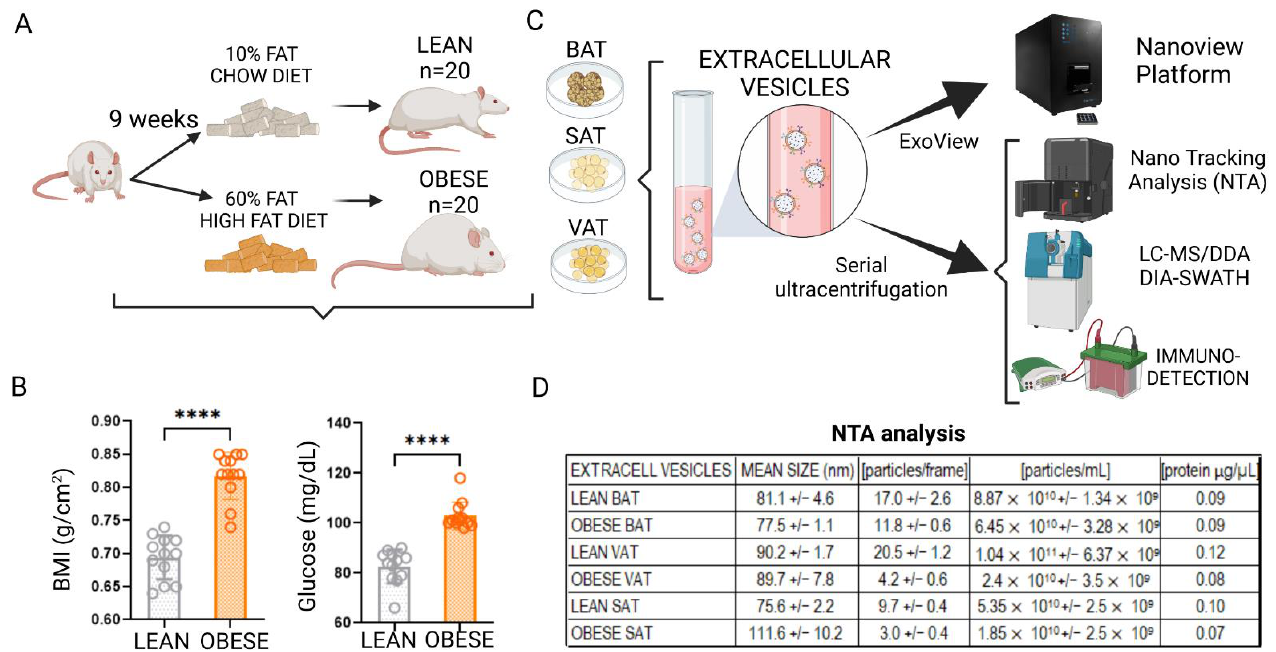
Figure 1. Establishment and characterization of a model of diet-induced obesity (DIO) for EV isolation. ( A ) A schematic of the animal model for obtaining adipose tissue from normal weight (control) or obese animals; ( B ) BMI (body mass index, g/cm 2 ) and basal glucose (mg/dL) in control (LFD, low fat diet, n = 20) and obese (60% HFD, n = 20) rats after 9 weeks of diet intervention. EVs were isolated from 1 g of whole adipose tissue explants (SAT, subcutaneous adipose tissue; VAT, visceral adipose tissue; BAT, brown adipose tissue) by ultracentrifugation for nanoparticle tracking analysis (NTA), proteomics (LC-MS qualitative DDA-/quantitative DIA-SWATH), and immunodetection; ( C ) additionally, EVs were directly analyzed using a ExoView platform. Particle concentration/mL according to size (nm) of EVs released from SAT, VAT and BAT of control and obese rats obtained by NTA; ( D ) a summary of the averages together with the standard deviations of the size (nm), particle/frame concentration, particles/mL, and protein concentration of these vesicles isolated from the secretome of 1 g of AT. Differences were analyzed using a Mann – Whitney U test; p ≤ 0.05 was considered to be statistically significant (**** p < 0.0001) (created with BioRender.com).